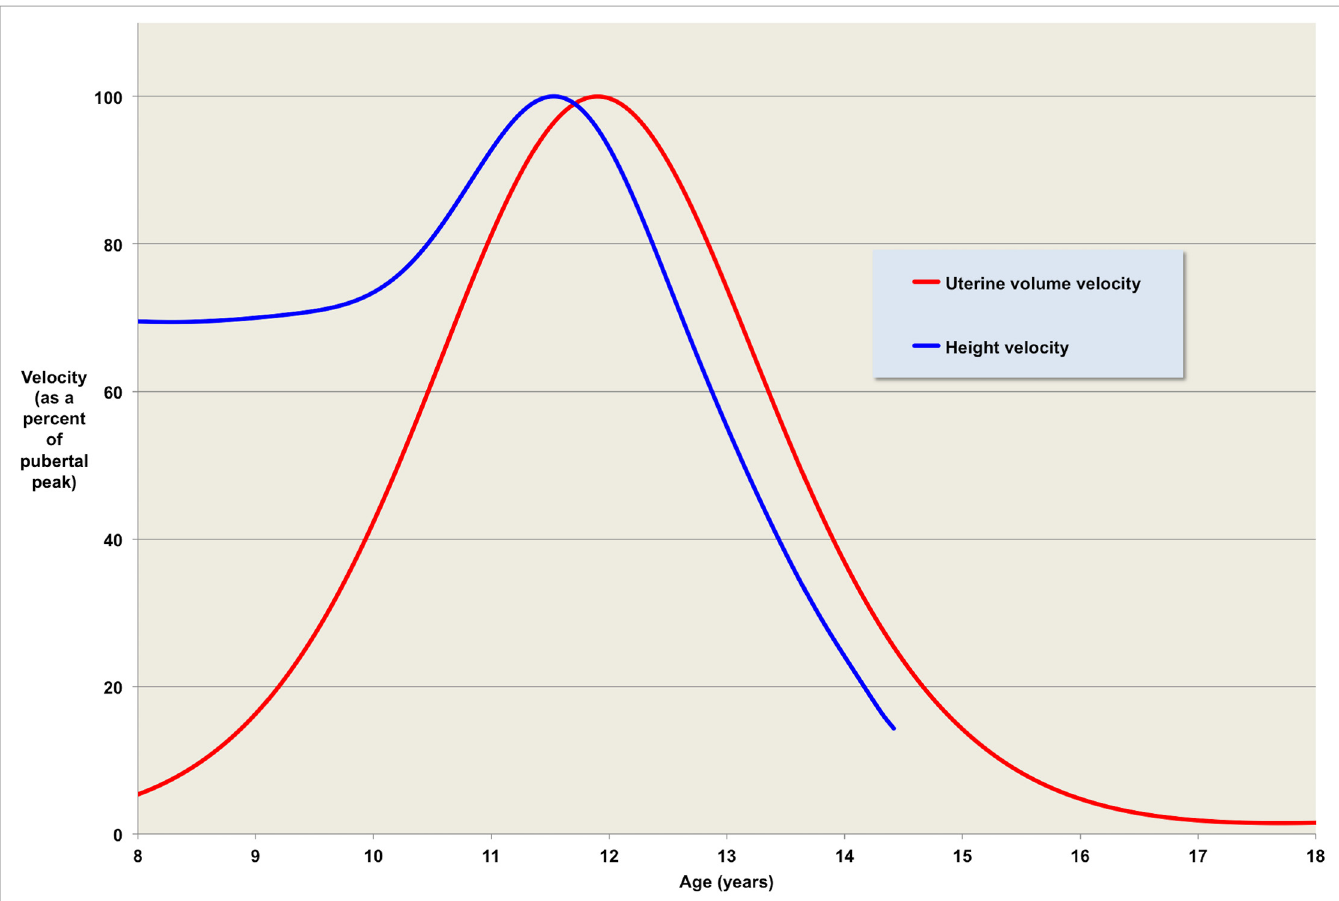
Fig 6. Velocity comparison. The first derivative of our uterine volume model as a percentage of the peak pubertal velocity is shown in red. For comparison, the height velocity for girls (based on data from [30]) is shown in